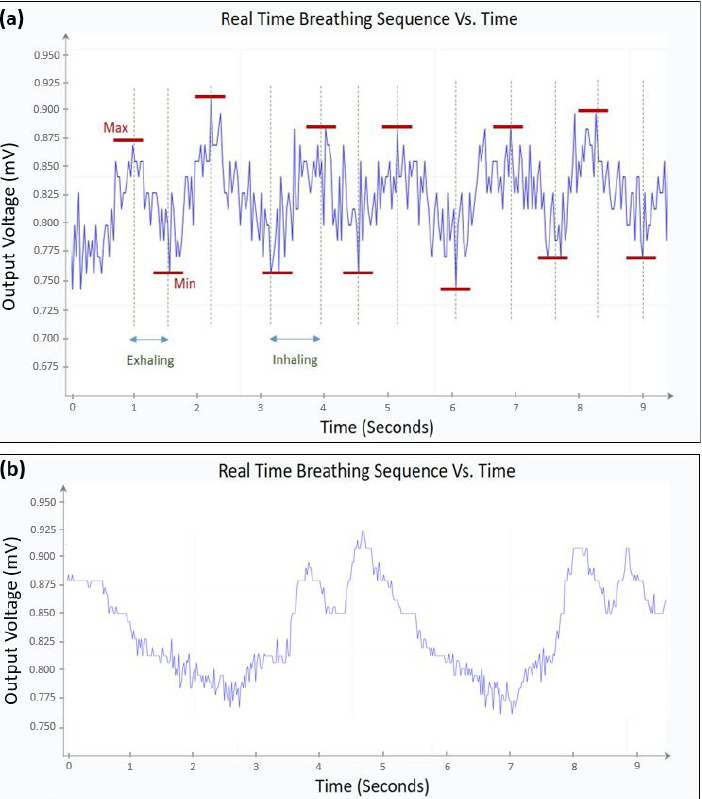
Figure 21. ( a ) Measured output voltage vs. time for a healthy patient. ( b ) Measured output voltage vs. time for a patient with sleep